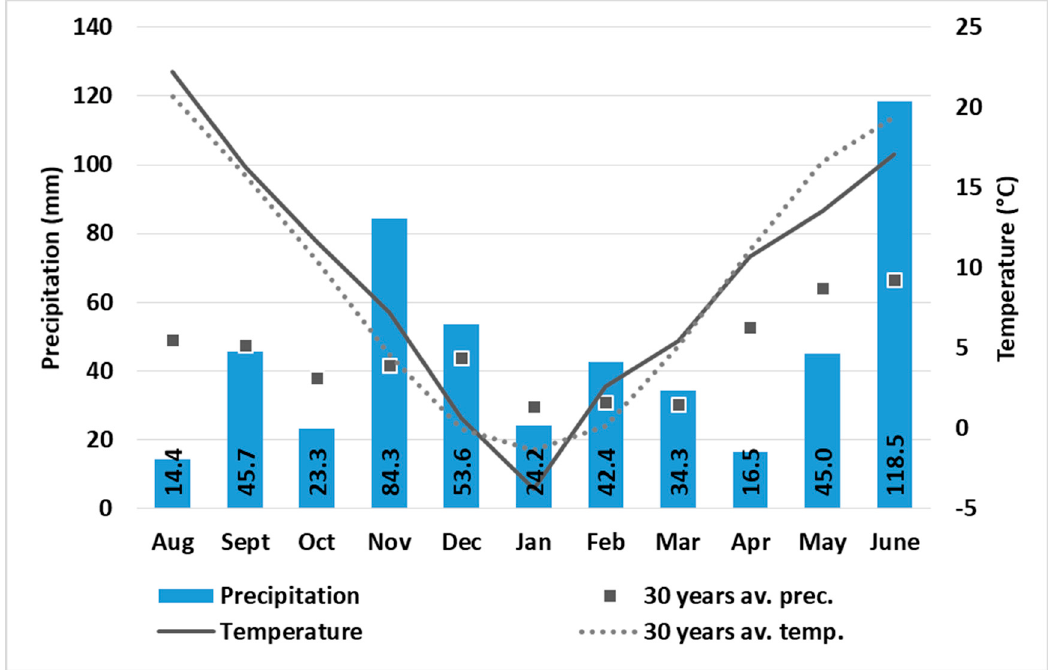
Figure 1. Monthly sums of precipitation and averages of temperature comparing to the 30 years’ average (Debrecen, 2019 / 2020). 30 years av. prec: 30 years average precipitation; 30 years av. temp: 30 years average temperature, numbers in the bars: sum precipitation of the month.